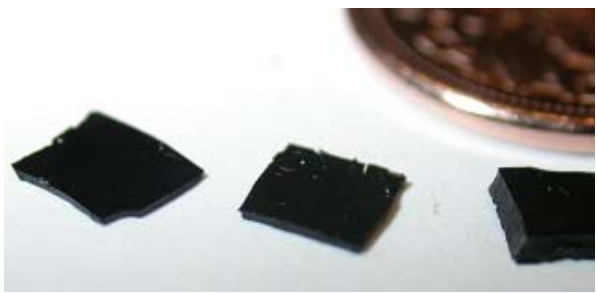
Figure 9. SiCN chips of different